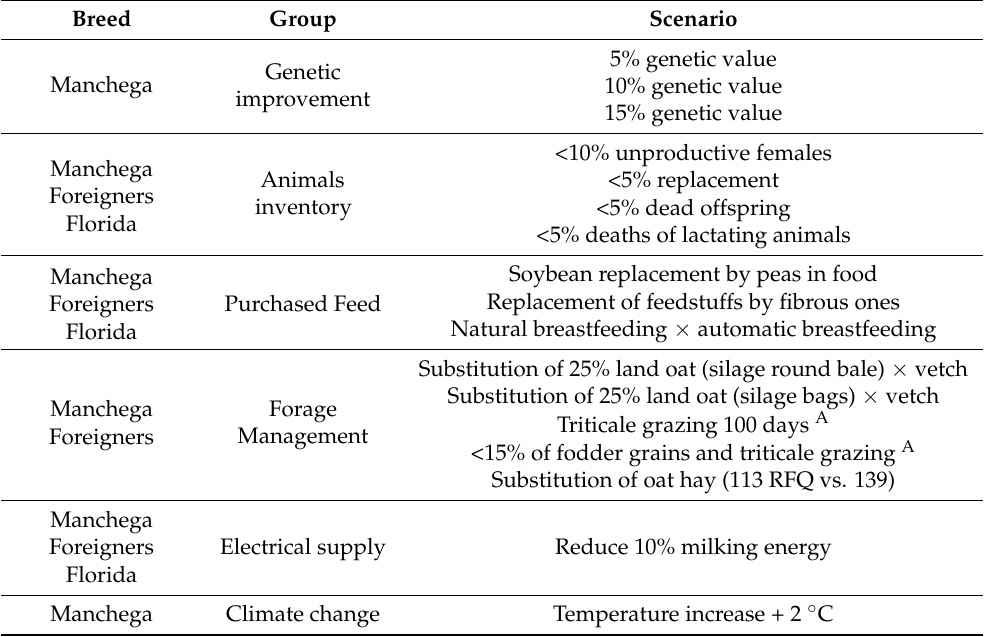
Table 2. Simulated